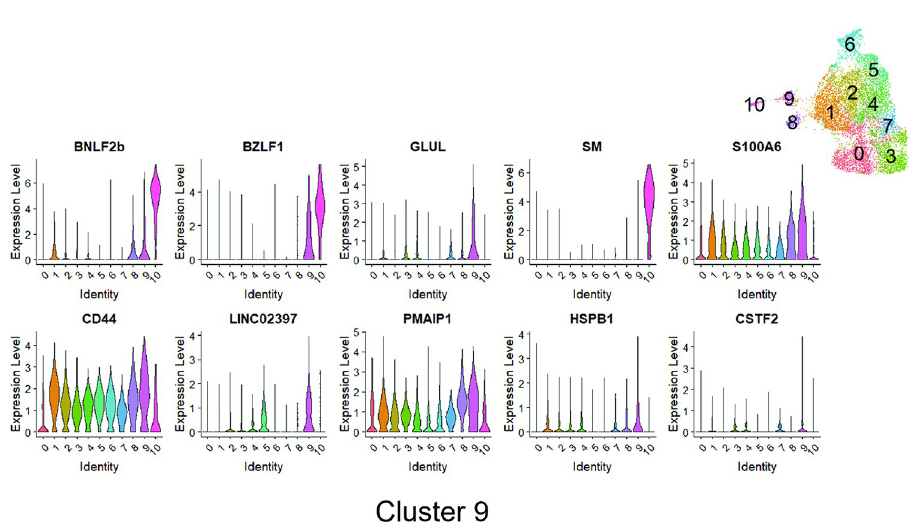
Fig 16. Gene expression analyses of Cluster 9. Violin plot of log normalized expression level of the top 10 differentially expressed genes sorted by average log2FC from MAST method (see Materials and Methods) across 11 identified clusters for Cluster 9 are